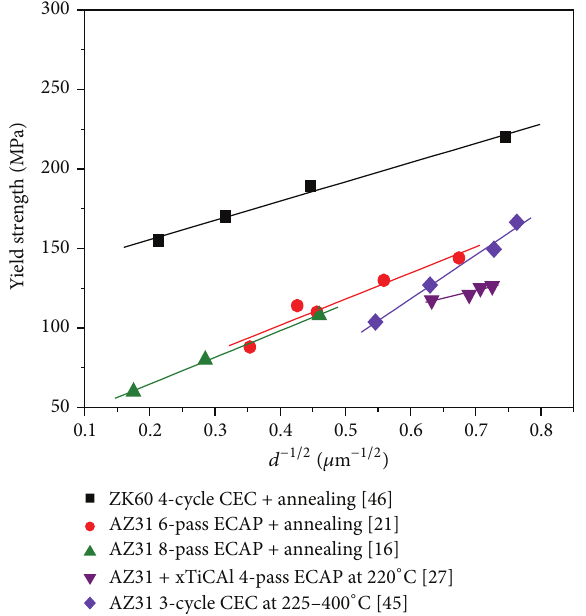
Figure 7: Grain size dependencies of yield strength of Mg alloy after SPD process and